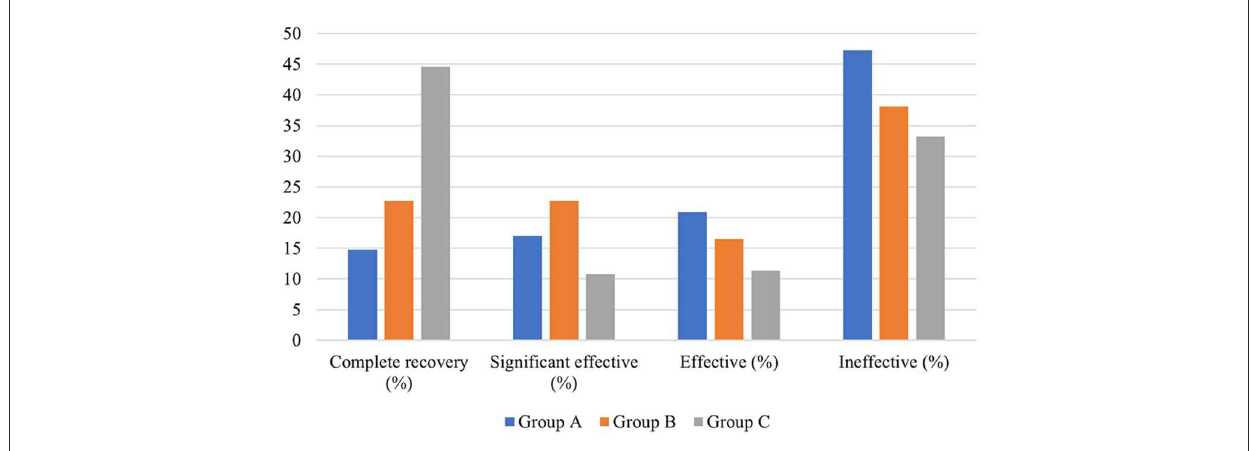
FIGURE4 Hearing efficacy of SSNHL patients in the three groups.